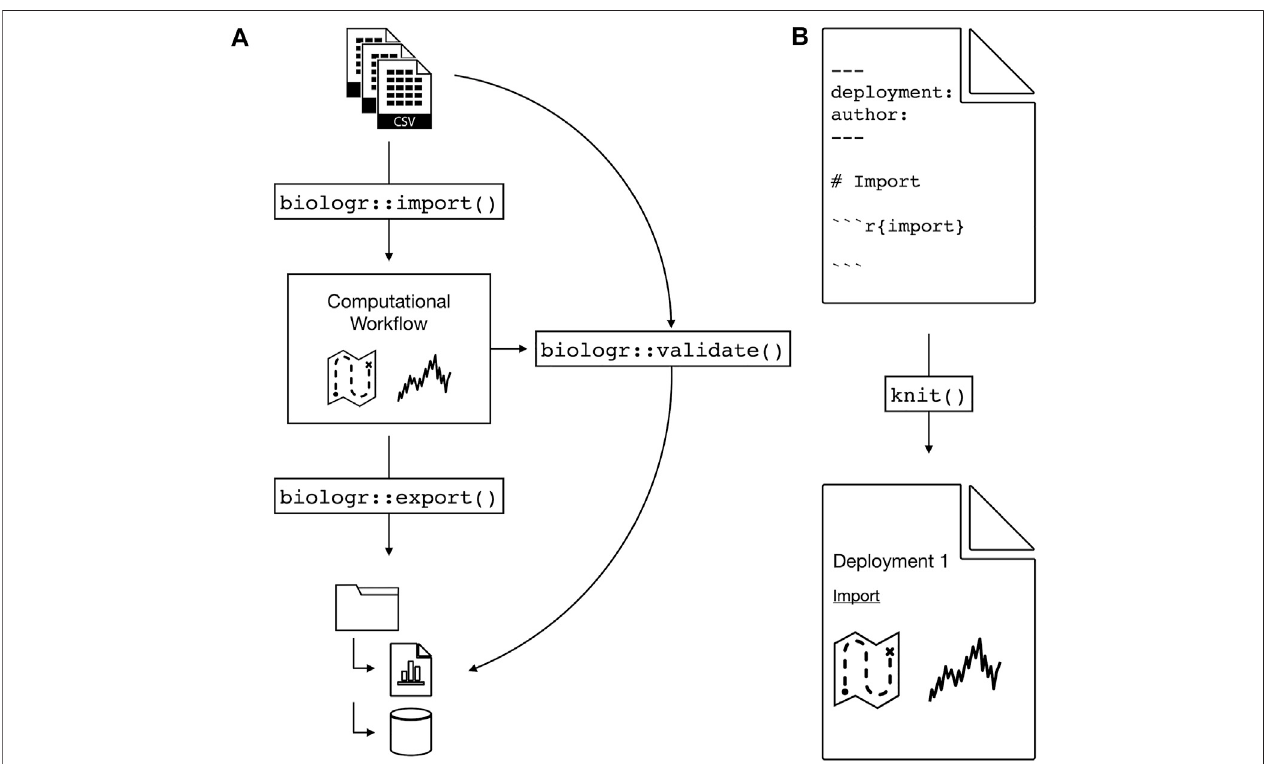
FIGURE1| Theproposed biologr Rpackage willprovidephysio-logging cyberinfrastructure. (A) Fromraw datatostandardized, reproducible data. Import and export functions ensure data standard compliance, e.g., fi le formats and directory structures. A validate function automatically veri fi es that the computational work fl ow (see (B) ) reproducibly generates the processed data. (B) biologr provides an R Markdown template (see section Introducing biologr ) for recording the work fl ow. The R Markdown knit command creates a report documenting data processing and interpretation, i.e., data provenance.